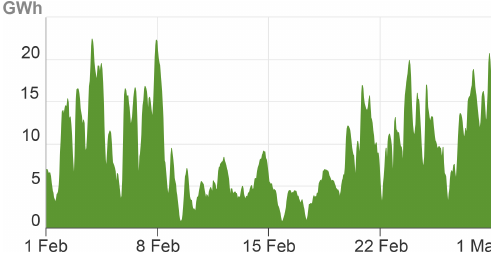
Figure 1. Texas region electricity generation by wind energy in February 2021. Winter storms occurred between 10 and 20 Febru- ary. Source: US Energy Information Administration, Hourly Elec- tric Grid Monitor, available at https://www.eia.gov/electricity/ gridmonitor (last access: 10 January